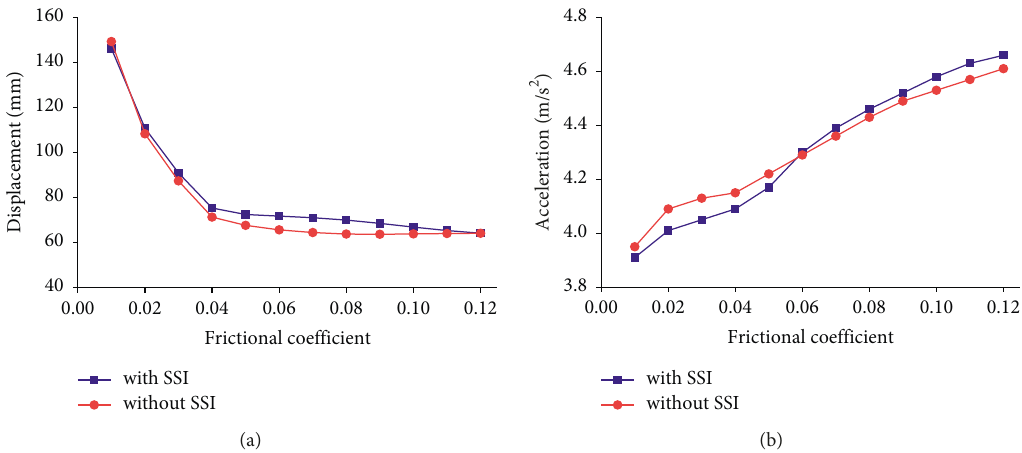
Figure 10: Comparison of the response amplitude of the main beam over the friction coefficient of FPS under ElCentro wave. (a) Displacement of the main beam. (b) Acceleration of the main